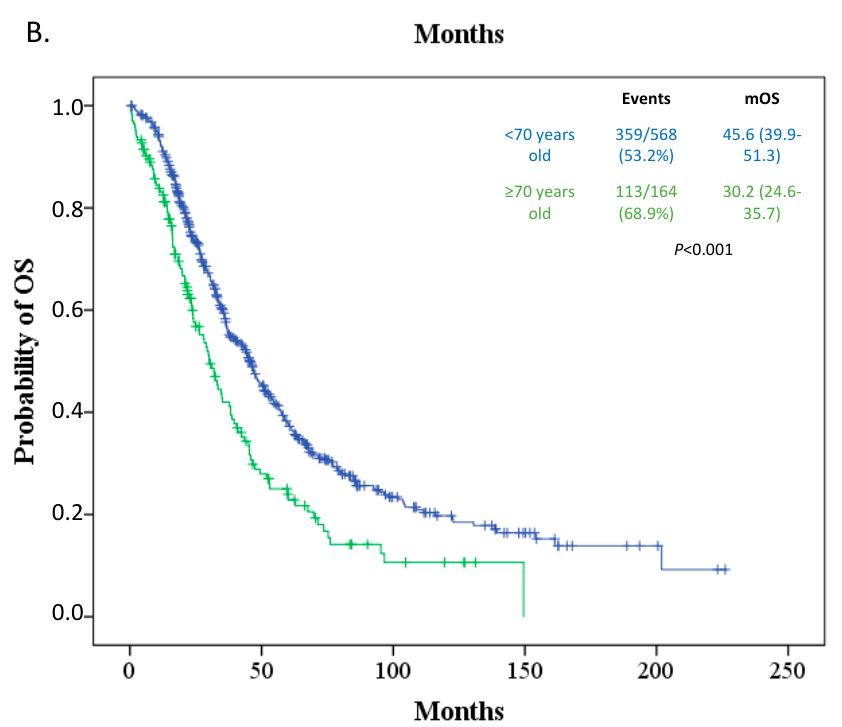
Figure 1. Kaplan-Meier curves showing median PFS ( A ) and OS ( B ) in patients younger (blue line) and equal to or older (green line) than 70 years of age.